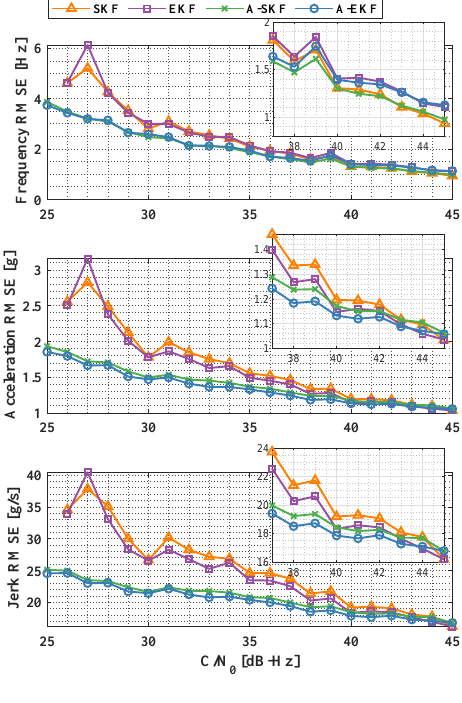
Figure 2. RMSEs of carrier tracking errors.